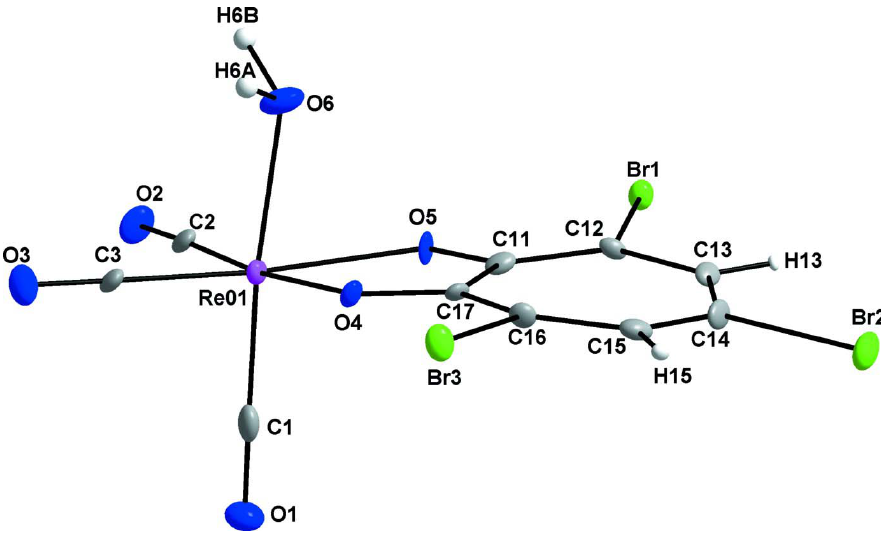
Figure 1 Representation of the title compound, showing the numbering scheme and displacement ellipsoids (50% probability). Aquatricarbonyl(3,5,7-tribromotropolonato)rhenium(I) methanol solvate Crystal